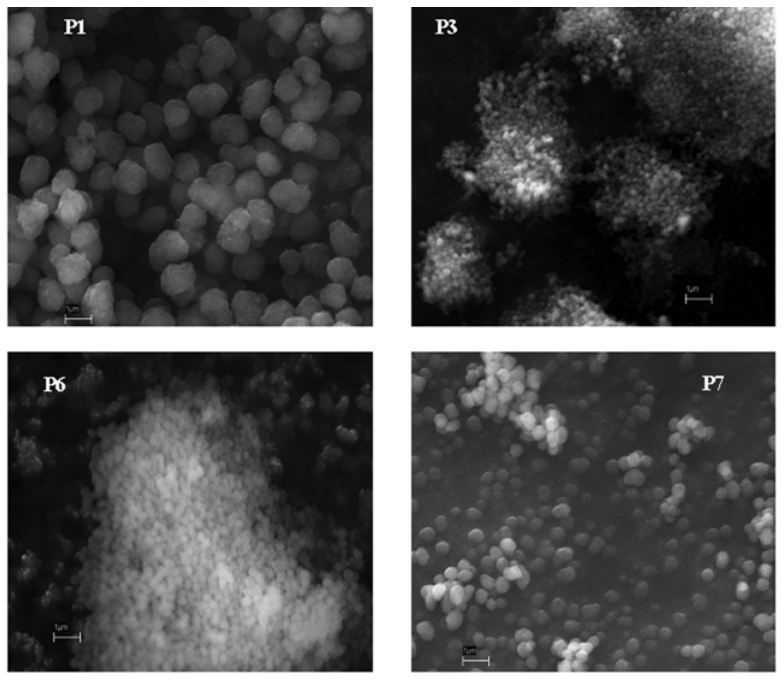
Figure 1. Scanning electron microscopy (SEM) images of P1, P3, P6 and P7 polymers